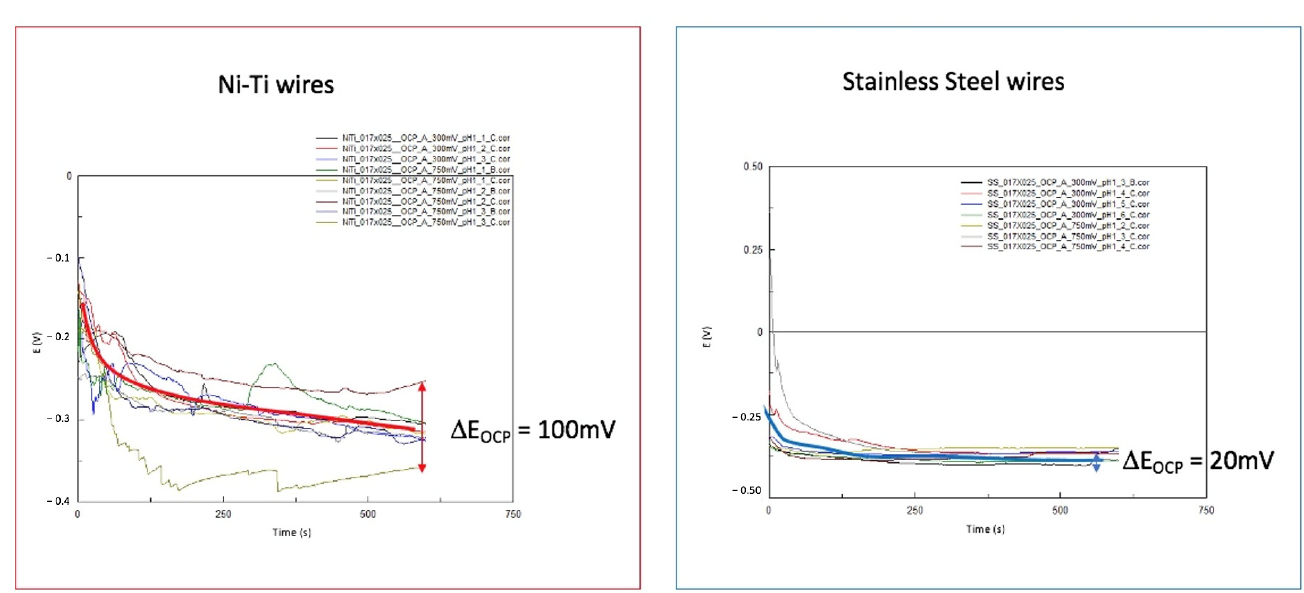
Figure 7. A collection of OCP E versus t curves from NiTi and SS wires at the beginning of EC measurements and simulations in Ringer’s solution at pH = 1, RT; the potential differences between the highest and lowest values are marked with red and blue arrows.